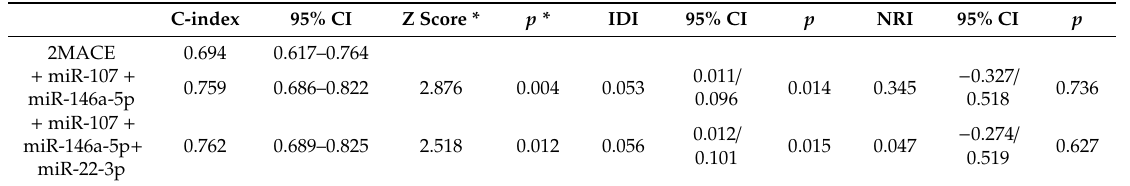
Table 3. C-indexes, c-indexes comparison, integrated discrimination improvement (IDI), and net reclassification improvement (NRI) after the addition of miRNAs to the 2MACE score.